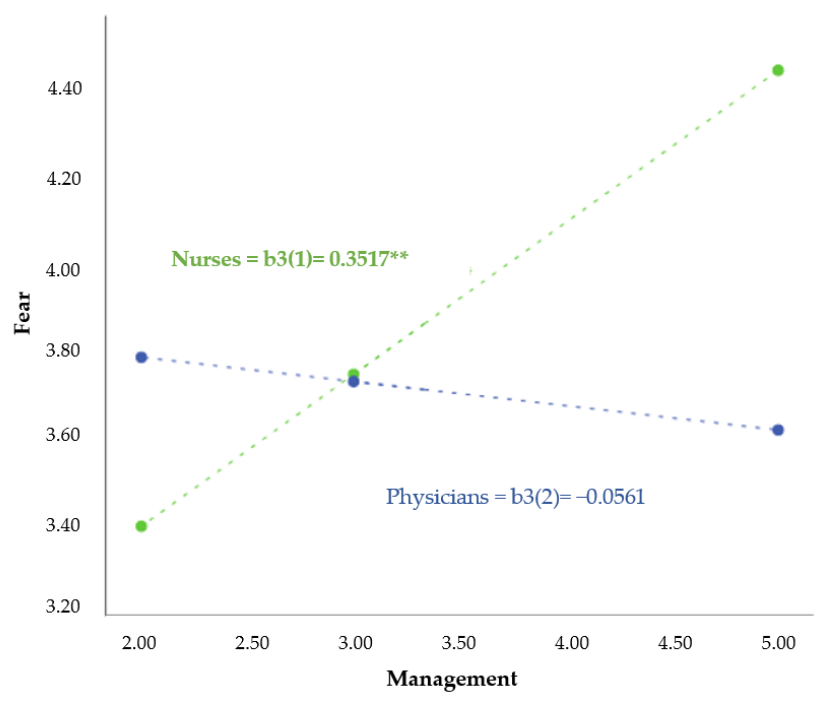
Figure 3. Moderation of profession variable on the effect of pandemic management over the fear of COVID-19 infection. ** p -value < 0.01.